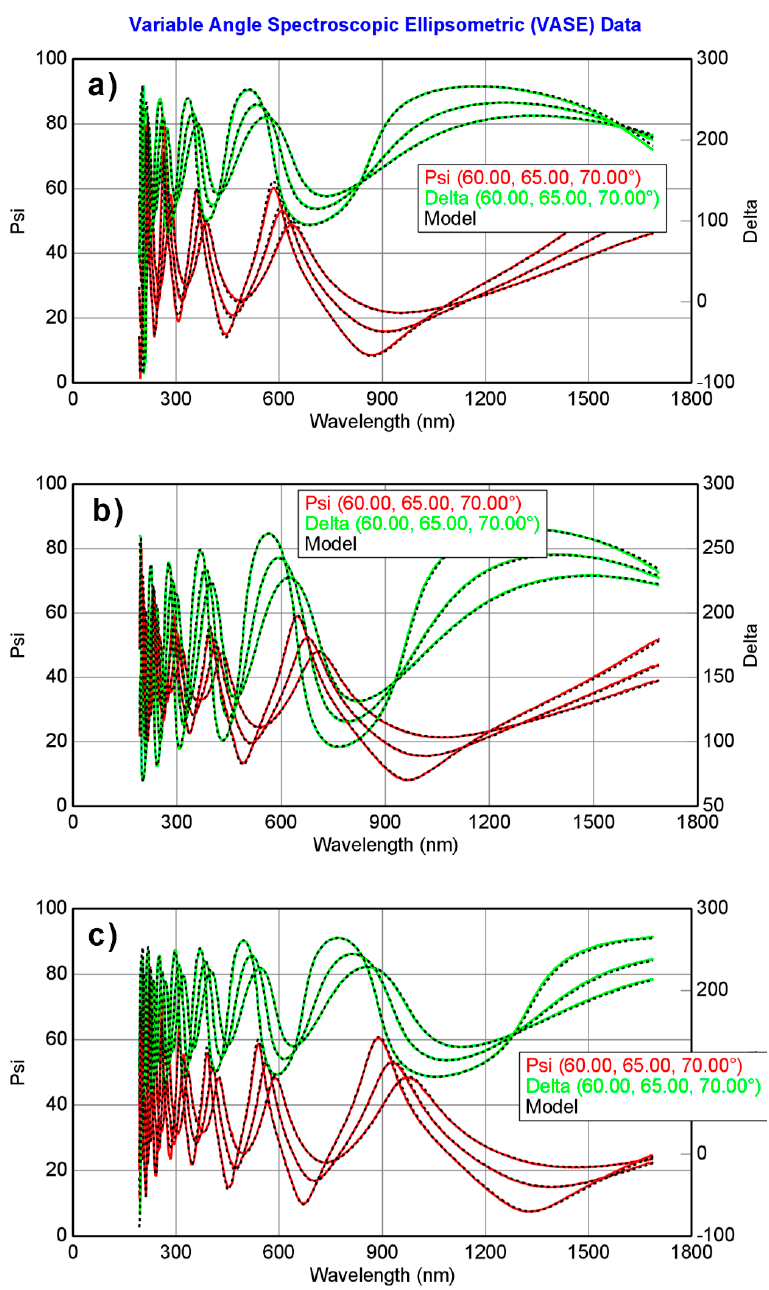
Figure 4. Spectral dependences with fitted model curves of ellipsometric angles for P1, P2, and P3 ( a , b, and c ), which represent porous silica thin films measured at 60°, 65°, and 70°, respectively. The dashed lines in Figure 4 represent the fitted results. As can be observed, the theoretical model of the porous silica film provided a very good fit. The spectral dispersion of the refractive index n and extinction coefficient k are shown in Figure 5.